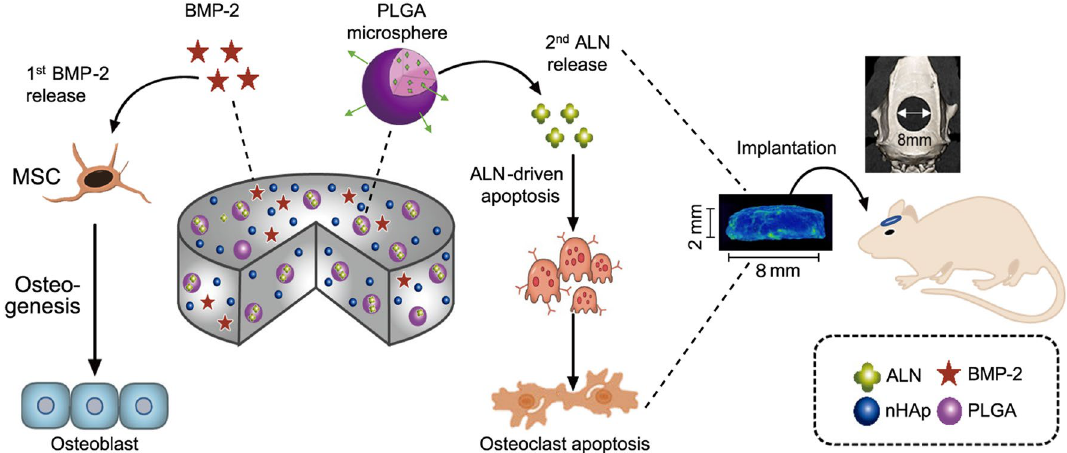
Figure 1. Schematic illustration of sequential dual-drug delivery using BMP-2 and